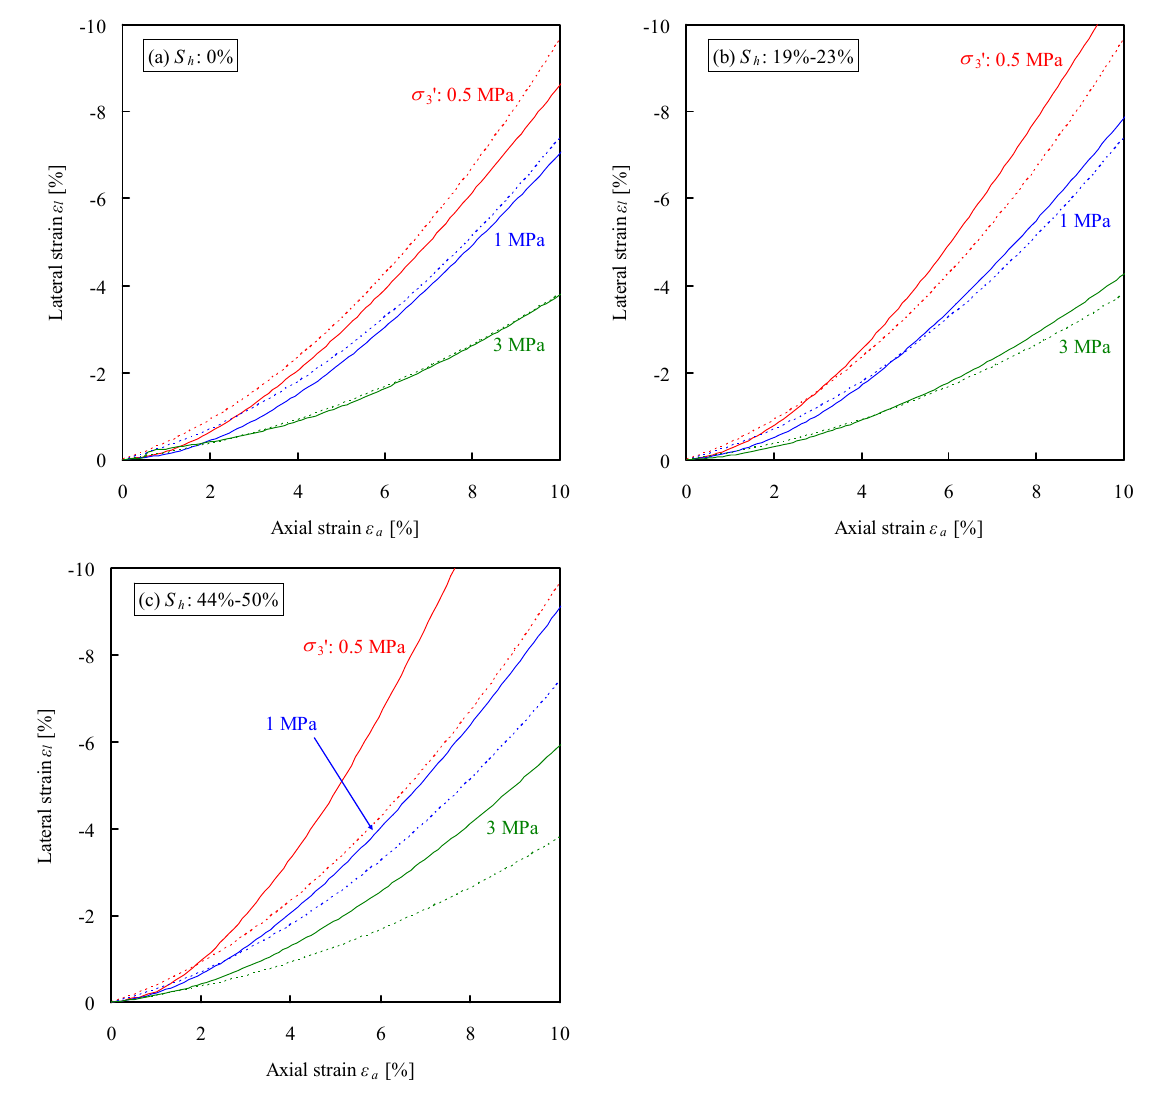
Figure 6. Experimental (solid lines) and calculated (broken lines) lateral strain ε for specimens formed by No. 8 silica sand with methane hydrate saturation axial strain ε a S of ( a ) 0%; ( b ) 19%–23% and ( c ) 44%–50%. Experimental results are taken from the h reference